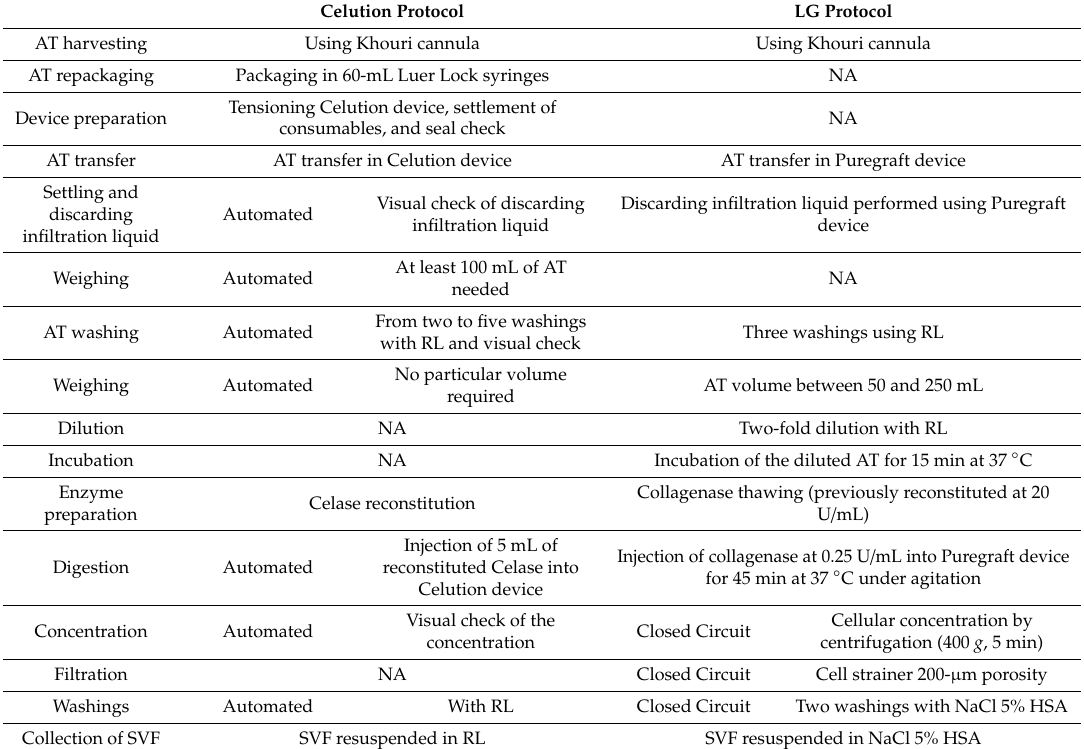
Table 1. Differences between LG and Celution protocols. LG: the developed SVF production process, named the person who originally developed it. NA : not applicable.